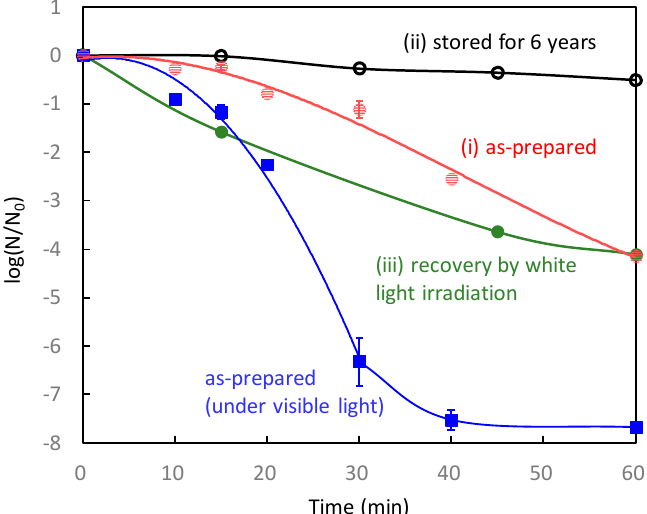
Figure 14. Inactivation of bacteriophage Q β by Cu x O / TiO 2 [Cu(I) / Cu(II) = 1.3] under the following sequential conditions: (i) as-prepared sample in the dark (red), (ii) the sample stored under ambient air for more than 6 years (black), (iii) after light irradiation onto the 6-year stored sample for 4 days (green). The antiviral tests of (i)–(iii) were performed under dark conditions. The results of the as-prepared Cu x O / TiO 2 sample under visible-light irradiation are also shown (blue).